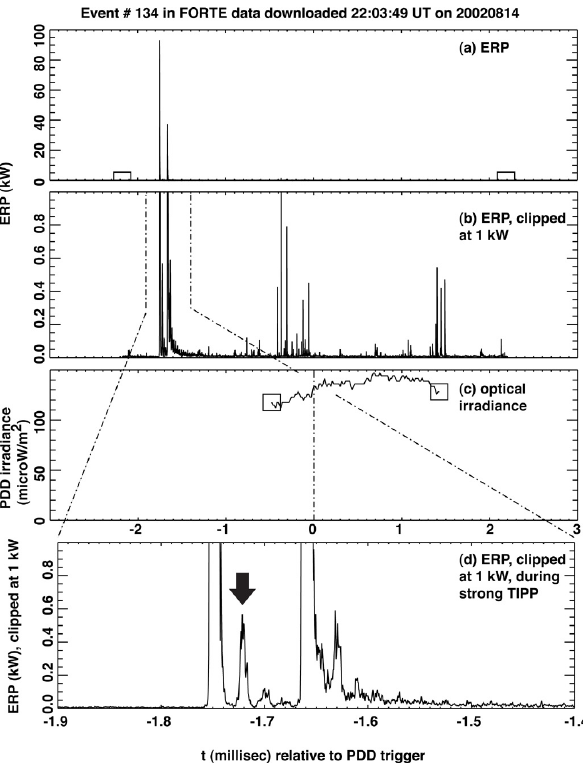
Fig. 8. Last of the six HUMR–PDD events of Table 4. (a) ERP vs. time. (b) ERP vs. time, clipped at 1kW on the ordinate. (c) Op- tical irradiance vs. time. (d) ERP vs. time, clipped at 1kW on the ordinate and restricted to the zoom limits shown in panel (b)